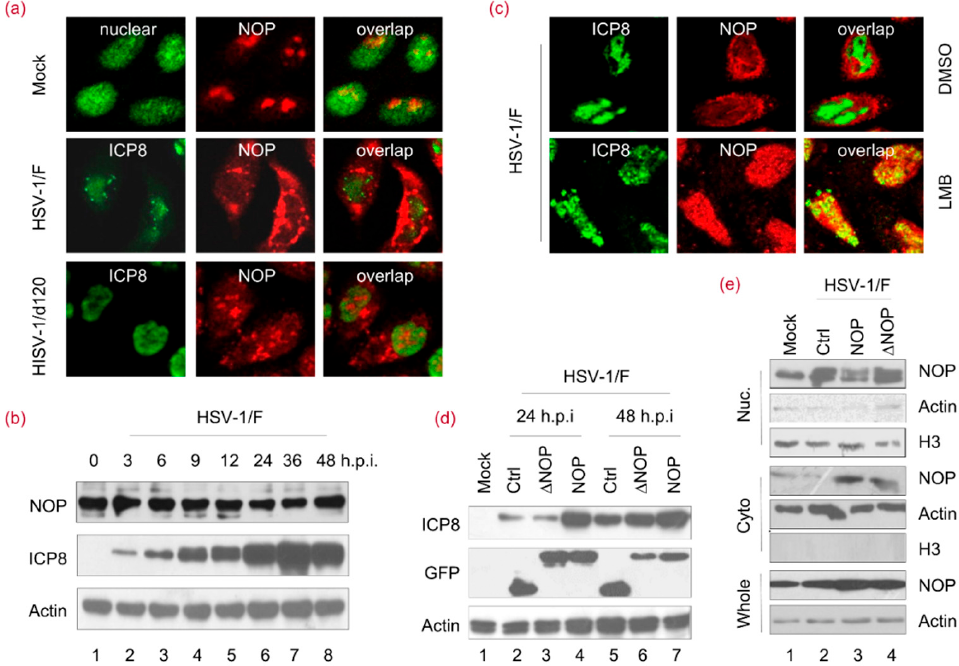
Figure 1. Cytoplasmic translocation of NOP53 plays an important role in the support of HSV-1 replication. ( a ) HeLa cells were mock-infected or exposed to 10 multiplicity of infection (MOI) of the herpes simplex virus (HSV-1/F) or d120 for 12 h. The cells were fixed and then stained with antibodies against ICP8 and NOP53 (NOP), and images were merged. All images were taken using 100 × objectives with an Olympus FluoView TM . ICP8 localizes in the nucleus and served to demarcate this structure [26]; ( b ) HeLa cells were infected with HSV-1/F at 1 MOI for 0, 3, 6, 9, 12, 24, 36, or 48 h; cell lysates were prepared, and NOP53 and HSV-ICP8 were measured by immunoblotting with specific antibodies, using actin as a control; ( c ) HeLa cells were exposed to 10 MOI of HSV-1/F for 12 h. The cells were then treated with 1 µ M of leptomycin B (LMB) or dimethyl sulfoxide (DMSO) for another 2 h. The cells were fixed and stained with antibodies against ICP8 and NOP53, and images were merged. All images were taken using 100 × objectives with an Olympus FluoView TM . ICP8 localizes in the nucleus and served to demarcate this structure [26]; ( d ) HeLa cells grown in T-25 flasks were transfected with a control (Ctrl) plasmid or plasmids encoding green fluorescent protein (GFP)-tagged wt NOP53 or the nuclear export sequence (NES) deletion mutant ( ∆ NOP) (5 µ g each) for 36 h. The cells were exposed to HSV-1/F at 0.1 MOI for 24 or 48 h. Cell lysates were analyzed by immunoblotting with antibodies against HSV-ICP8, NOP53, and actin; ( e ) HeLa cells were transfected a Ctrl plasmid or plasmids expressing Flag-tagged NOP53 or ∆ NOP53. The cells were then mock-infected or infected with HSV-1/F at 1 MOI for 24 h. The cells were harvested, and the nuclear and cytoplasmic fractions were isolated and analyzed by immunoblotting with an antibody against NOP53. Actin and H3 were used as loading controls for cytoplasmic and nuclear proteins,